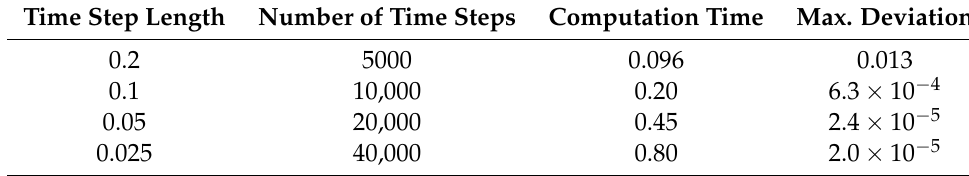
Table A2. Effect of the time step on the deviation and computation